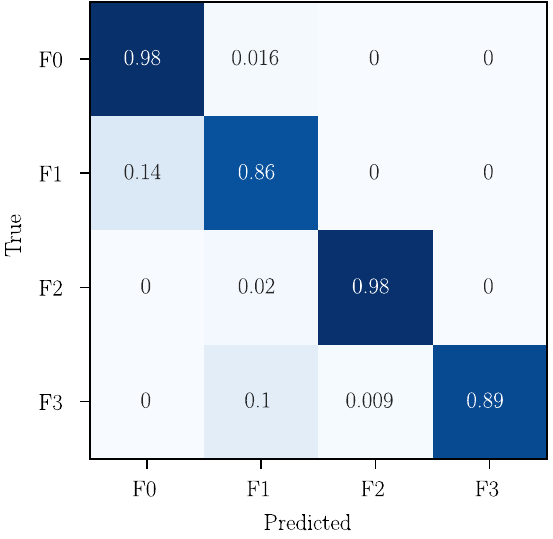
Figure 11. Confusion matrix for the target dataset FDD with a model trained using the source dataset samples and fine-tuned using a few target dataset samples (Source, Target → Target).